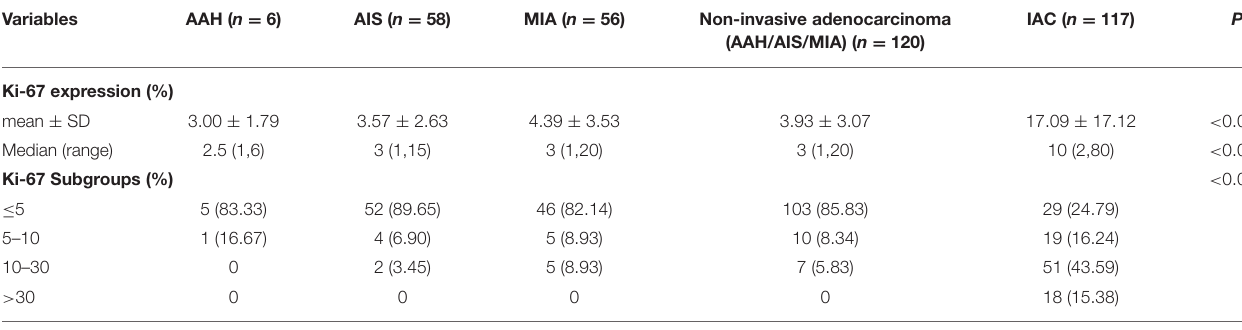
TABLE 2 | The expression level of Ki-67 in various pathological subtypes of lung adenocarcinoma. Variables